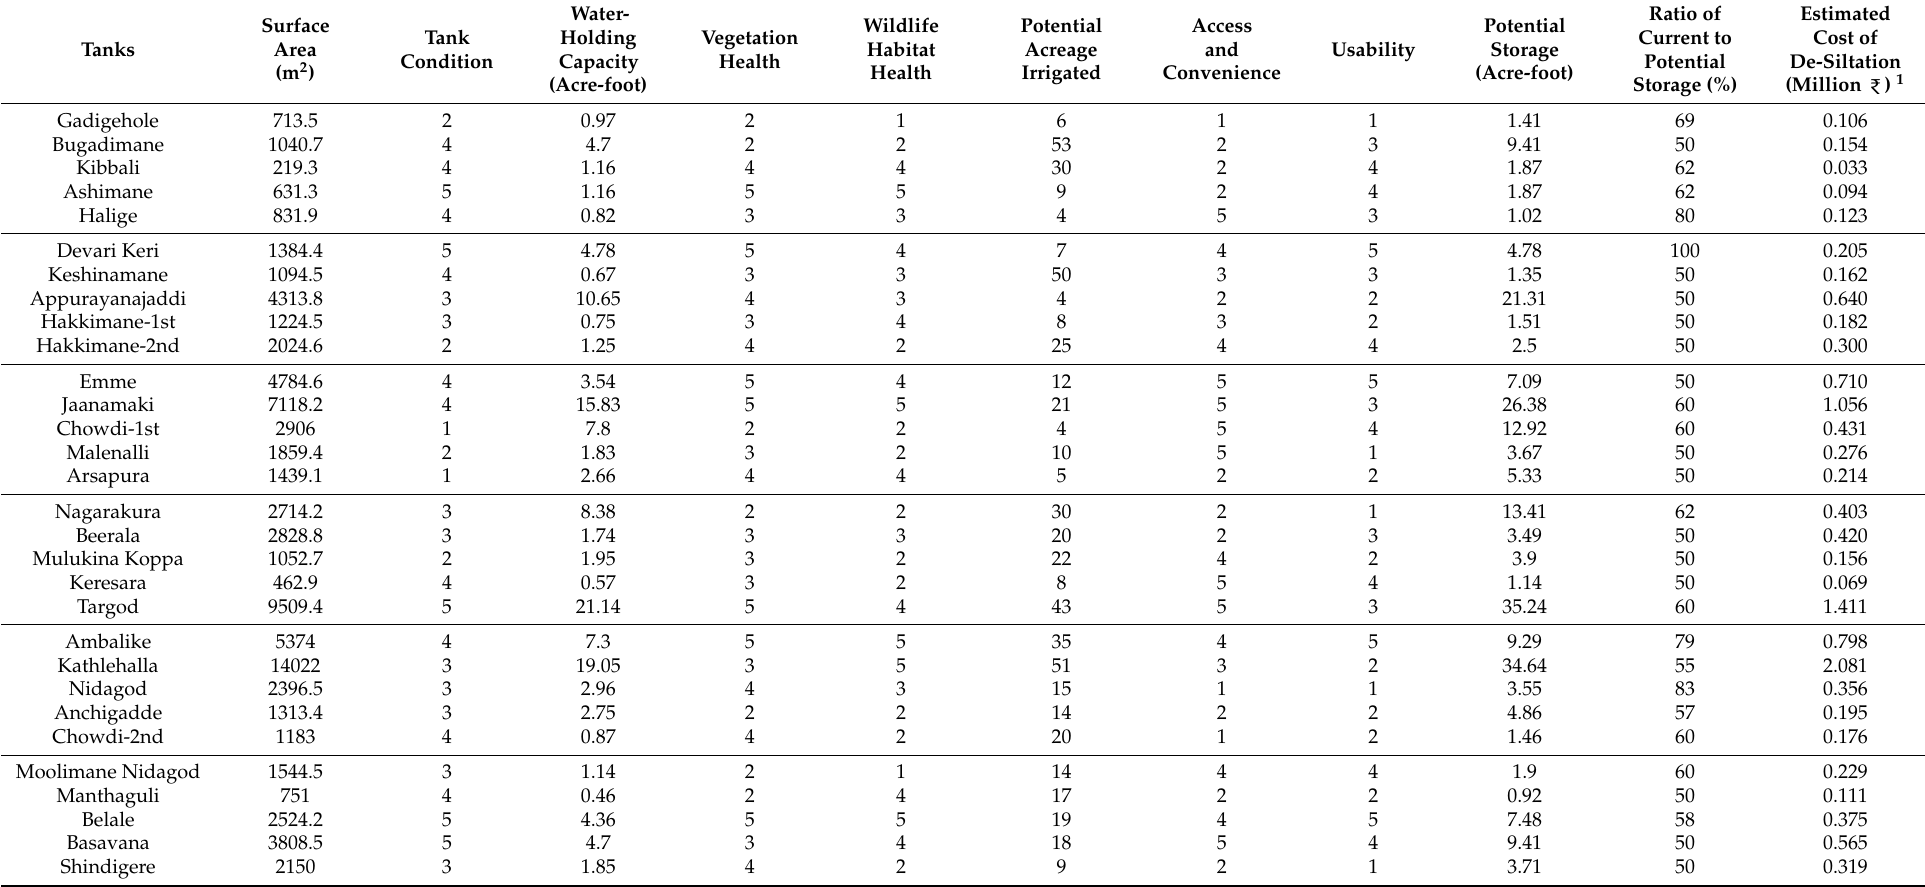
Table 3. Performance indicator values of irrigation tanks in the study